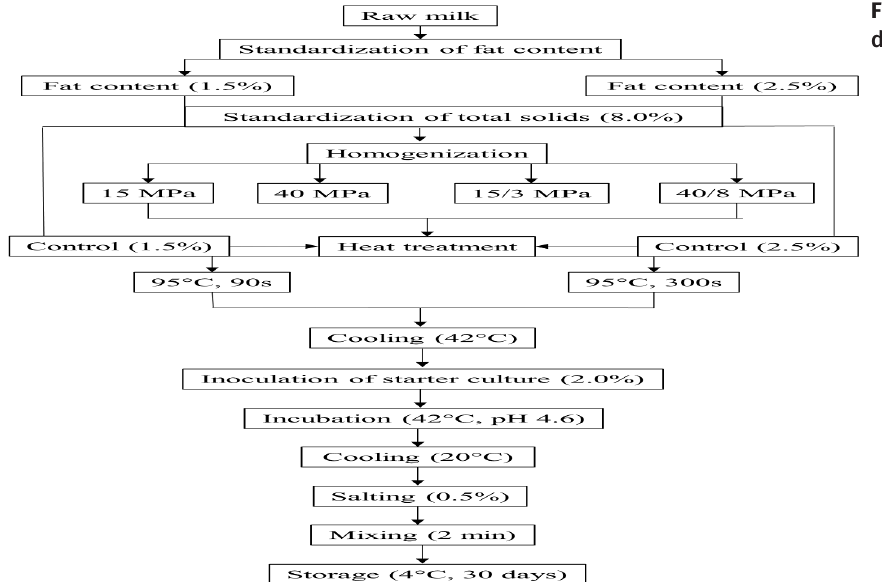
Figure 1. The process flow diagram of ayran